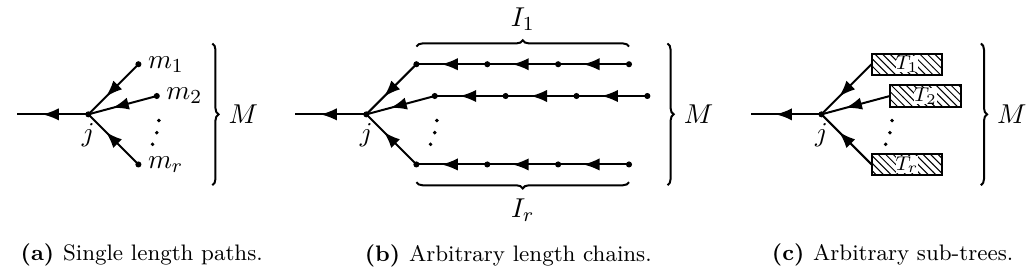
Figure 2 . Merging of branches at the vertex j